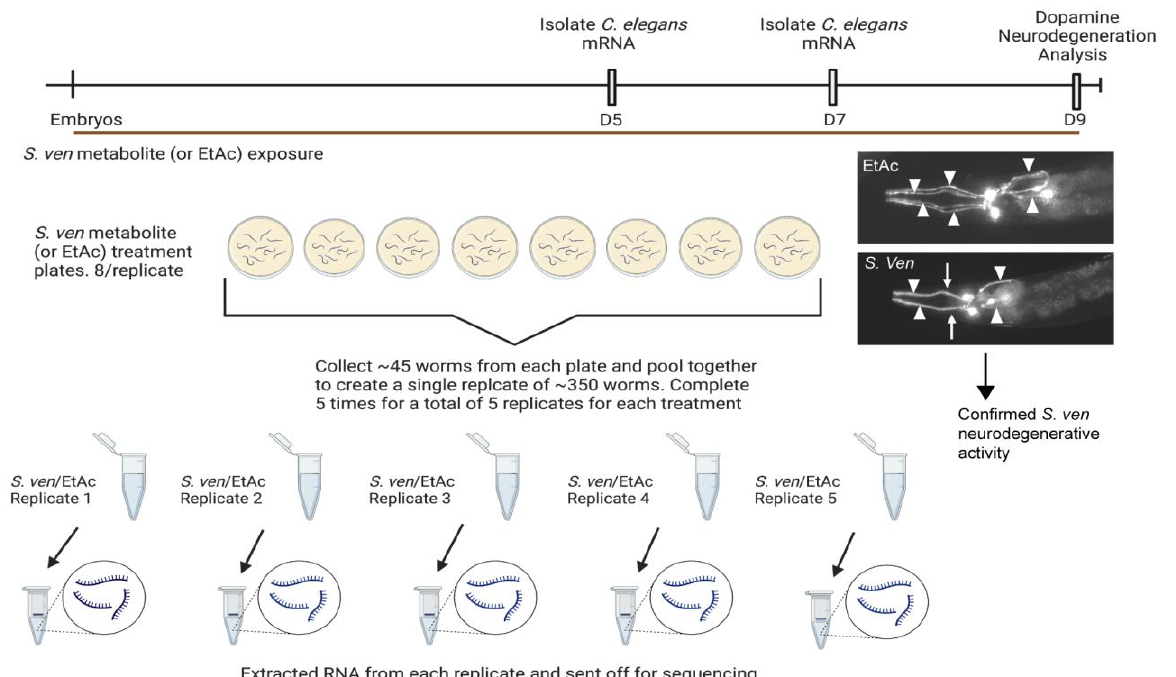
Figure 1. Schematic diagram of C. elegans in preparation for RNA sequencing analysis following S. ven metabolite exposure. Worms were grown in the presence of chronic S. ven metabolite or EtAc exposure for the duration of the experiment. On Days 5 and 7 of adulthood, mRNA was extracted from whole C. elegans animals. On each day, ~350 worms were collected from each treatment to comprise a single replicate. mRNA was extracted and subsequently sequenced. To ensure S. ven metabolite contained active neurodegenerative capacity, additional worms from the exposure were grown until day 9 of adulthood and then analyzed for dopaminergic (DA) neurodegeneration. These worms expressed GFP in the DA neurons (P dat-1 ::GFP), which readily allows for phenotypic analysis of neurodegenerative phenotypes. Representative images of the anterior region of C. elegans expressing P dat-1 ::GFP are displayed in this figure. There are six DA neurons in the anterior region of a healthy worm. Here, DA neurons on day 9 of adulthood when exposed to EtAc (top) or S. ven metabolite (bottom) are shown. Arrowheads indicate intact neurons, whereas arrows indicate degenerated neurons. Created with BioRender.com (accessed on 9 September 2022).